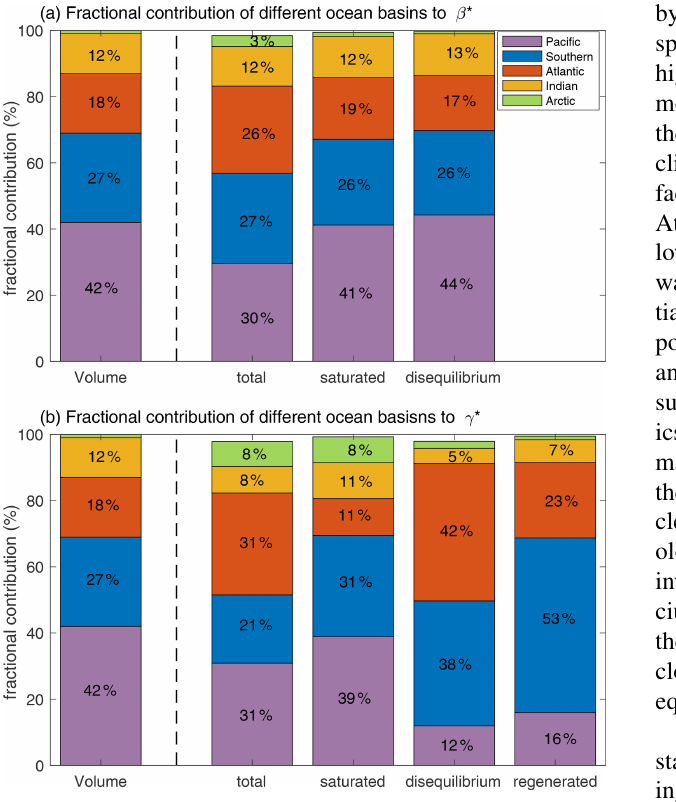
Figure 6. The fractional contribution (in %) of different ocean basins to the total volume of the ocean and to the ocean carbon cycle feedback parameters based on carbon storage, along with the contribution from the saturated, disequilibrium and regenerated carbon pools based on the inter-model mean of 11 CMIP6 mod- els (Table 1): (a) carbon–concentration feedback parameter, β ∗ , and (b) carbon–climate feedback parameter, γ ∗ . The estimates are based on the fully coupled simulation (COU) and the biogeochemi- cally coupled simulation (BGC) under the 1%yr − 1 increasing CO 2 experiment. Diagnostics are from years 121 to 140 (the 20 years up to quadrupling of atmospheric CO 2 ). The regenerated part of β ∗ is omitted as its contribution is negligible in all basins (Fig. 5a). The Arctic Ocean has a fractional volume of ∼ 1% of the global ocean and a fractional contribution of 1.2%, 0.7%, 2% and 1% to β sat , β dis , γ dis and γ reg , respectively (not explicitly shown in the figure). The combined fractional contribution of the five ocean basins to β ∗ and γ ∗ is less than 100% due to a small contribution, < 2%, from semi-enclosed seas with a fractional volume of less than 0.5% of the global ocean (Supplement Fig.